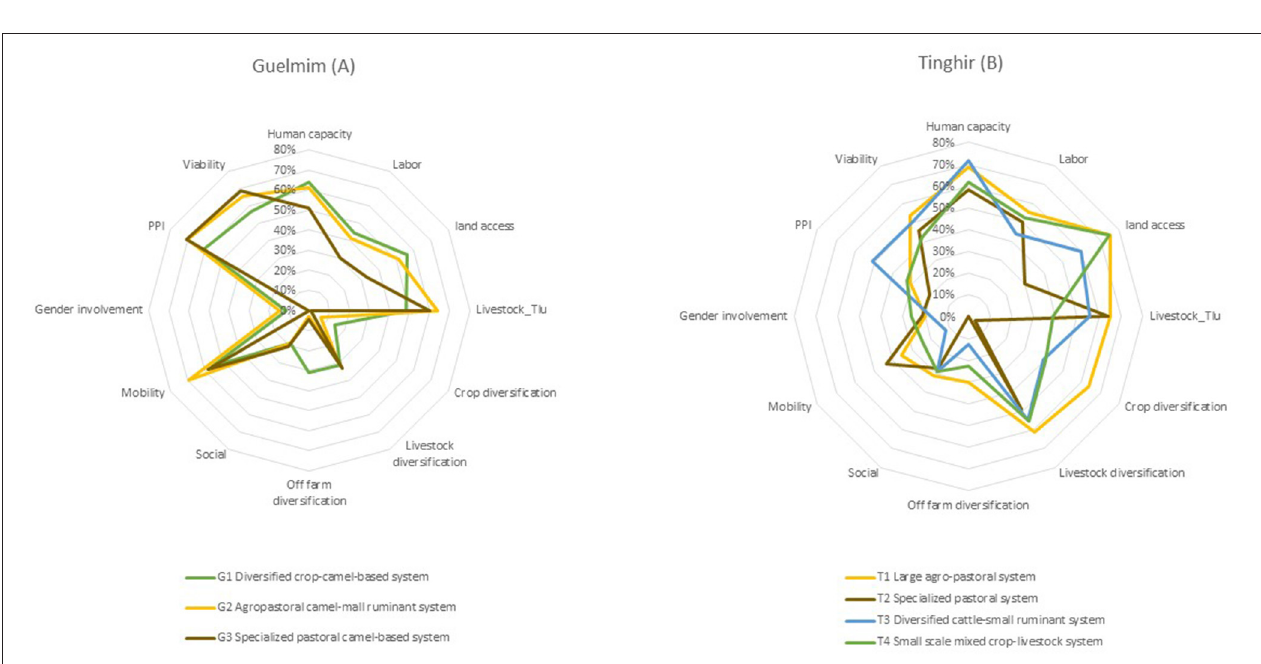
difference between PPI and Viability indicators is not